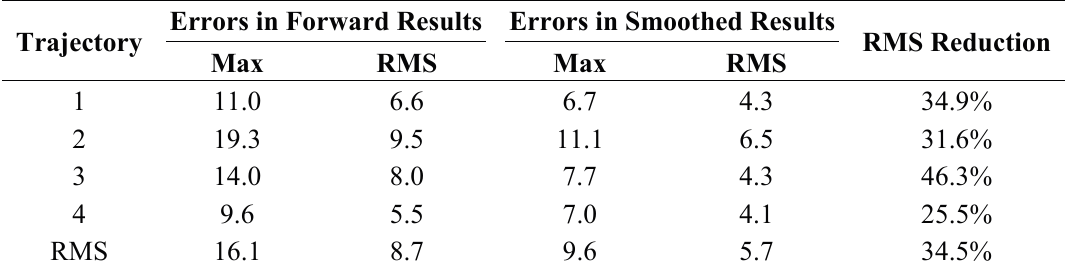
Figure 6. Error distances of sensor-based navigation solutions ( a ) Trajectory 1; ( b ) Trajectory 2; ( c ) Trajectory 3; ( d ) Trajectory 4. Table 1. Statistical values of sensor-based navigation